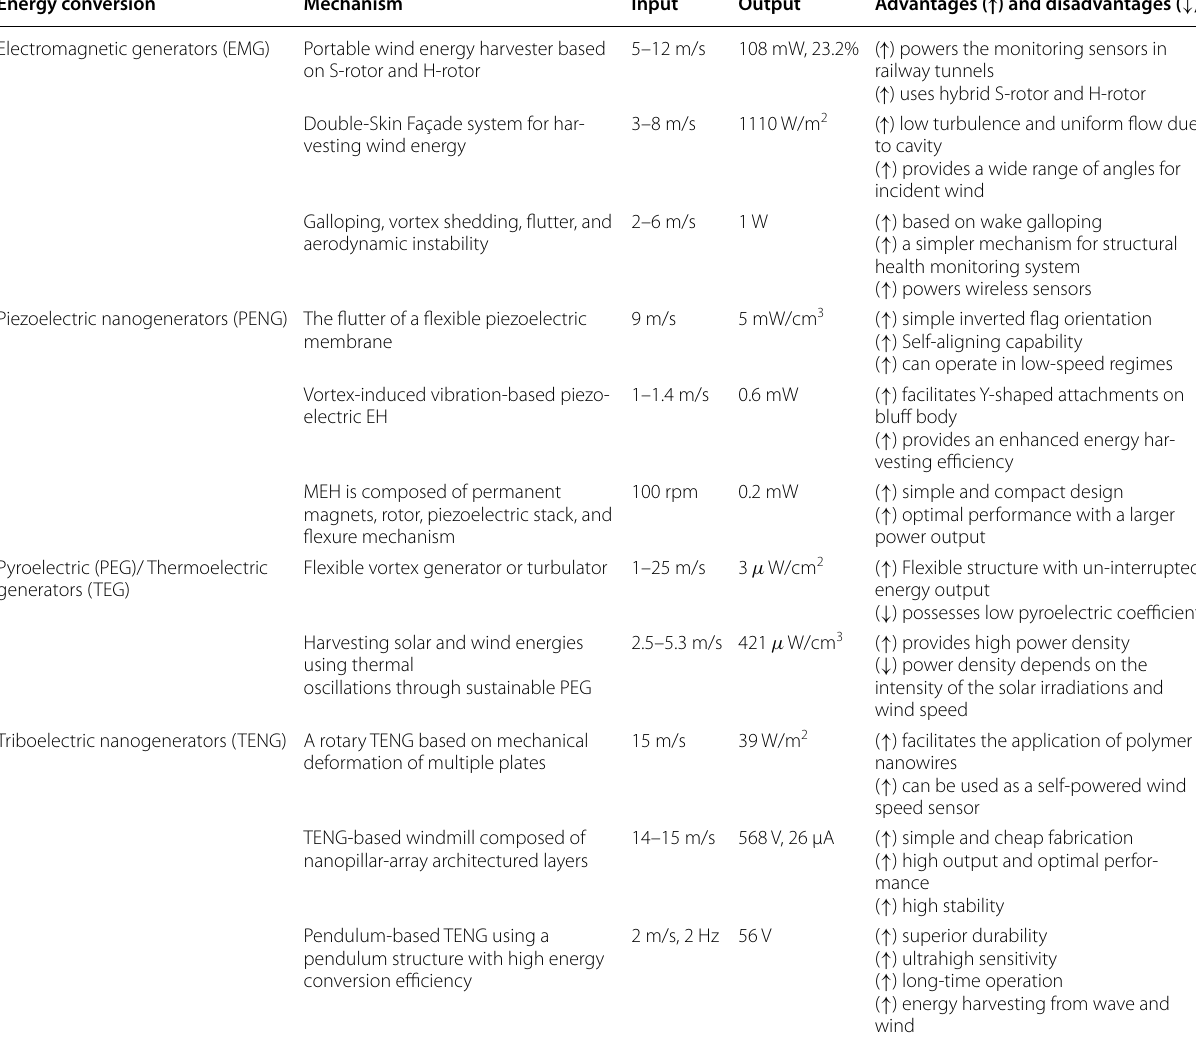
The references of the research papers cited in this table are provided in the Additional file